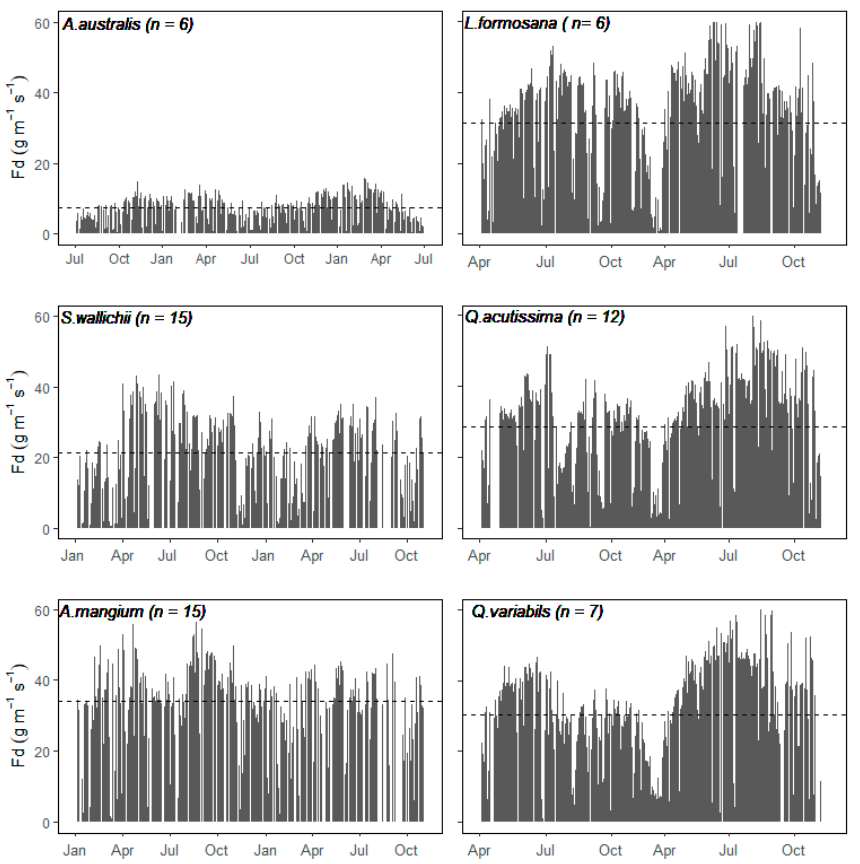
Figure 2. Seasonal course of daily max sap flow density for six dominant species at our research site during two years of study period. Dashed line in each panel represents average value for that species.